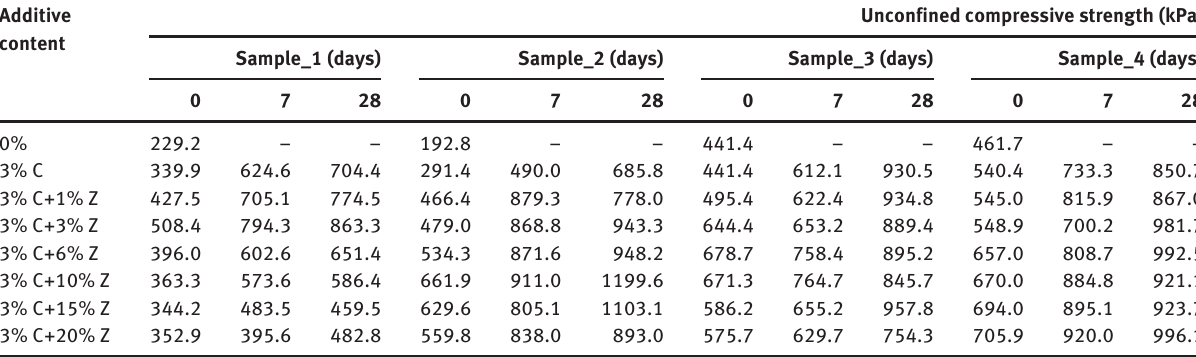
Table 5 Influence of additive contents and curing time on the UCS test results of the soil samples. Additive